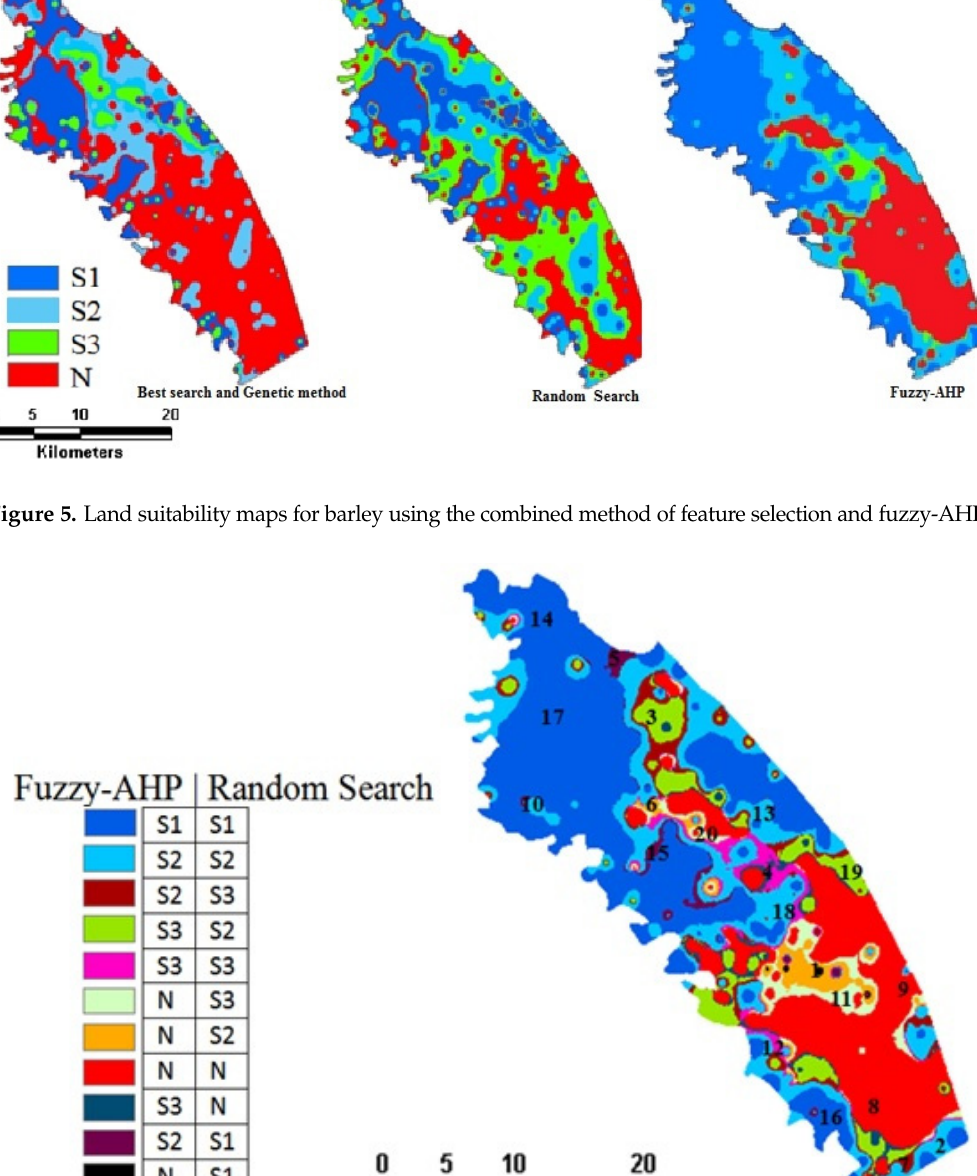
Figure 6. Comparison map showing correspondence between fuzzy-AHP and random search results.